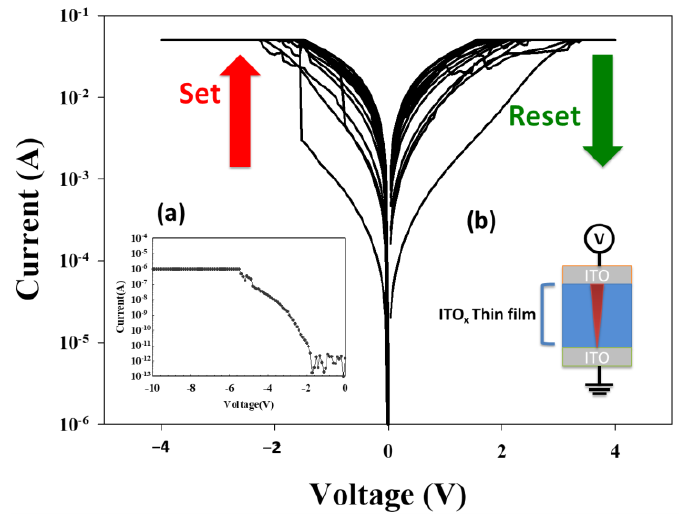
Figure 7. The I-V curves of ITO/ITO X /ITO RRAM for ( a ) initial electrical forming process, and ( b ) electrical filament mechanism model on the MIM structure.